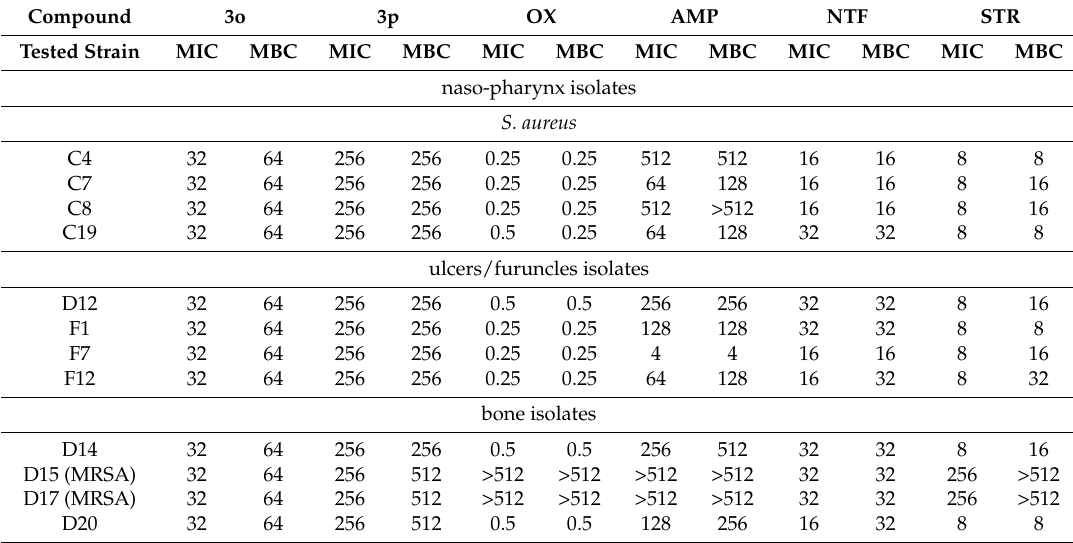
Table 8. In vitro activity of 3o and 3p against clinical isolates of S. aureus expressed as a minimal inhibitory concentration (MIC) ( µ g/mL) and a minimal bactericidal concentration (MBC) ( µ g/mL). OX: oxacillin, AMP: ampicillin, NTF: nitrofurantoin, STR: streptomycin.